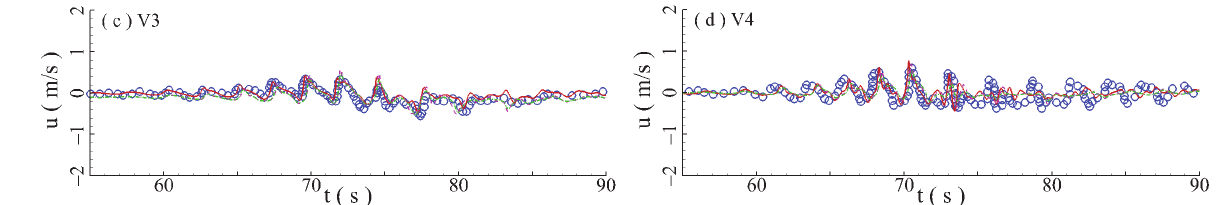
Figure 5. Comparisons of the horizontal velocities obtained numerically with the experimental results; ( a ) V1; ( b ) V2; ( c ) V3; ( d ) V4.